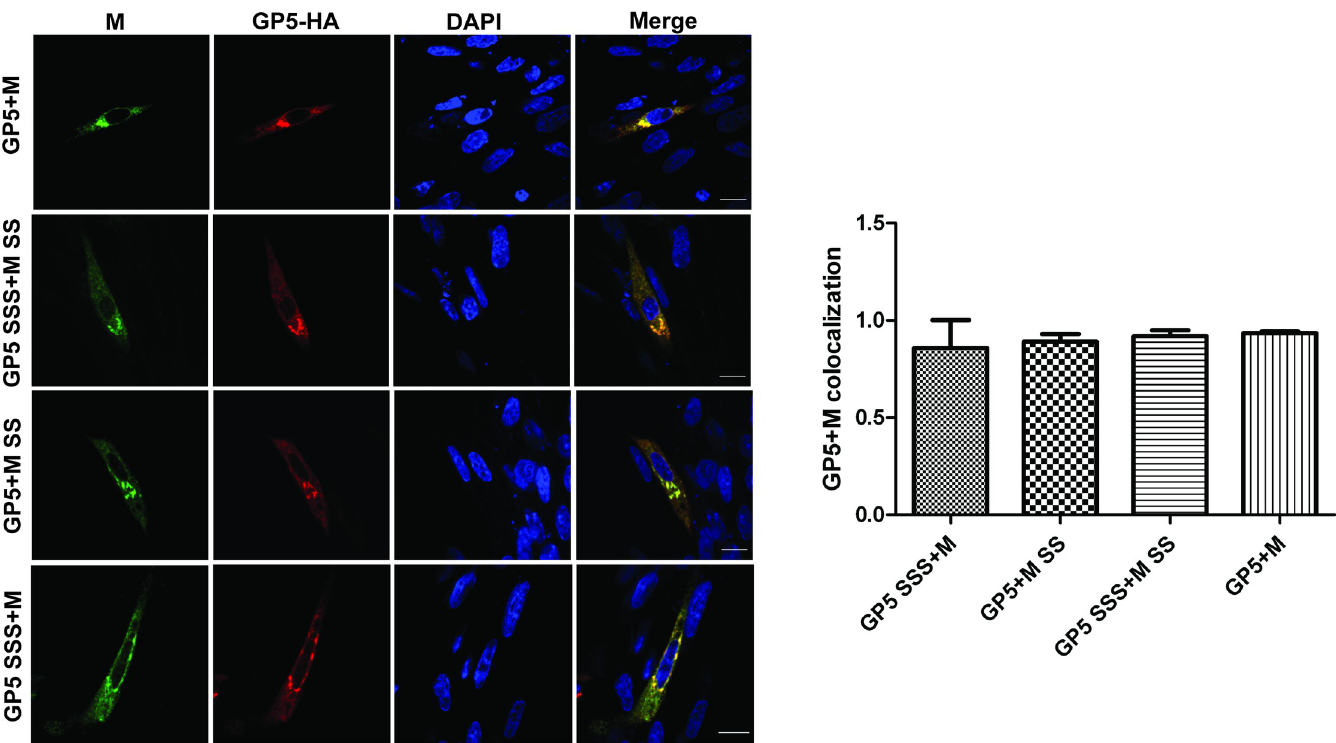
Fig 7. Non palmitoylated GP5 co-localizes with M in a perinuclear region. BHK-21 cells were transfected with GP5-HA wt and M-His wt (upper panel), or with non- acylated GP5-HA SSS and M-His SS (second from above), or with GP5-HA wt and non-acylated M-His SS (second from below), or with non-acylated GP5-HA SSS and M-His wt (lower panel). GP5 was stained with polyclonal antibodies against the HA-tag followed by secondary anti-rabbit antibodies coupled to Alexa Fluor-568 fluor, M with monoclonal anti-M antibodies followed by secondary anti-mice antibodies coupled to Alexa Fluor-488 and nuclei with DAPI. Right panel: Co-localization of M with GP5 from at least 40 cells was quantified with the Pearson’s correlation coefficient method using the JACoP plugin of the ImageJ software. Around 80% of M and GP5 pixels overlapped regardless of whether they are palmitoylated or not.